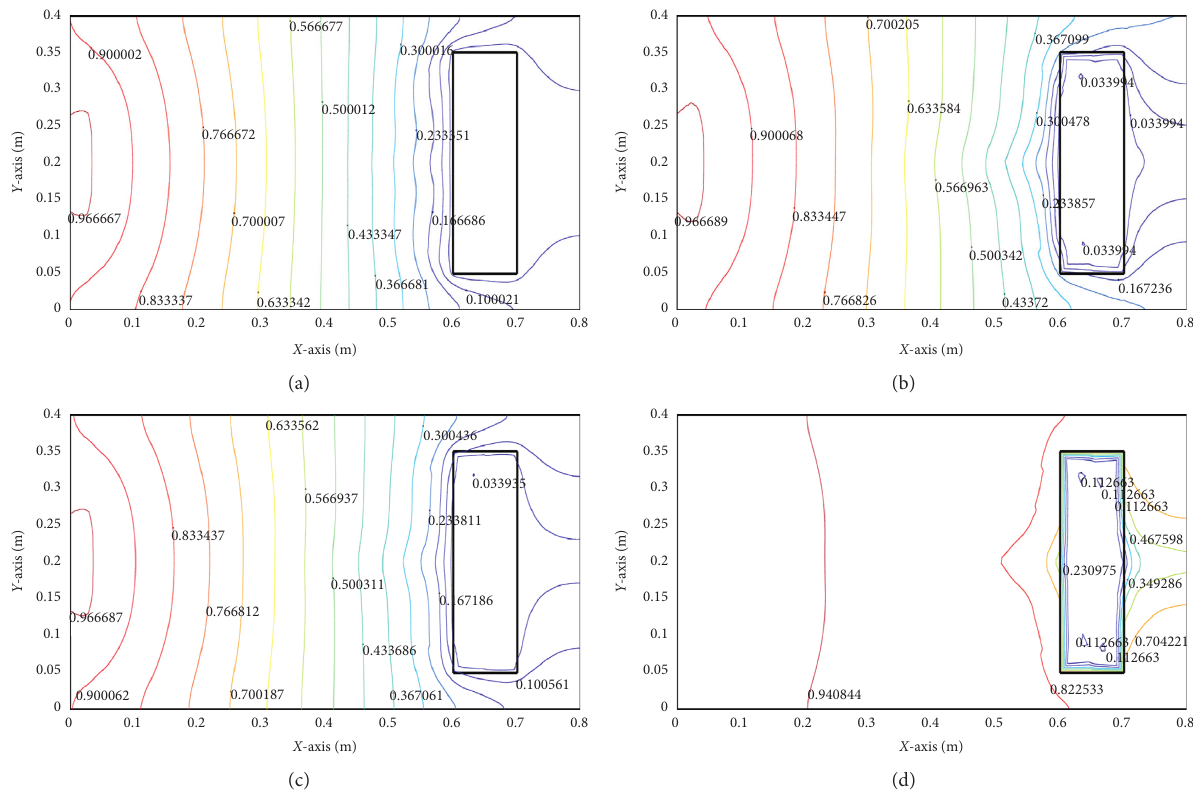
Figure 6: Normalized concentration contours of lead and nickel ions across the 2D sandy soil packed tank in the presence of WFS-LPB as predicted by the COMSOL software at different values of travel time. (a) Time � 1 day; contour: normalized concentration of lead ions. (b) Time � 10 days; contour: normalized concentration of lead ions. (c) Time � 1 day; contour: normalized concentration of nickel ions. (d) Time � 10 days; contour: normalized concentration of nickel